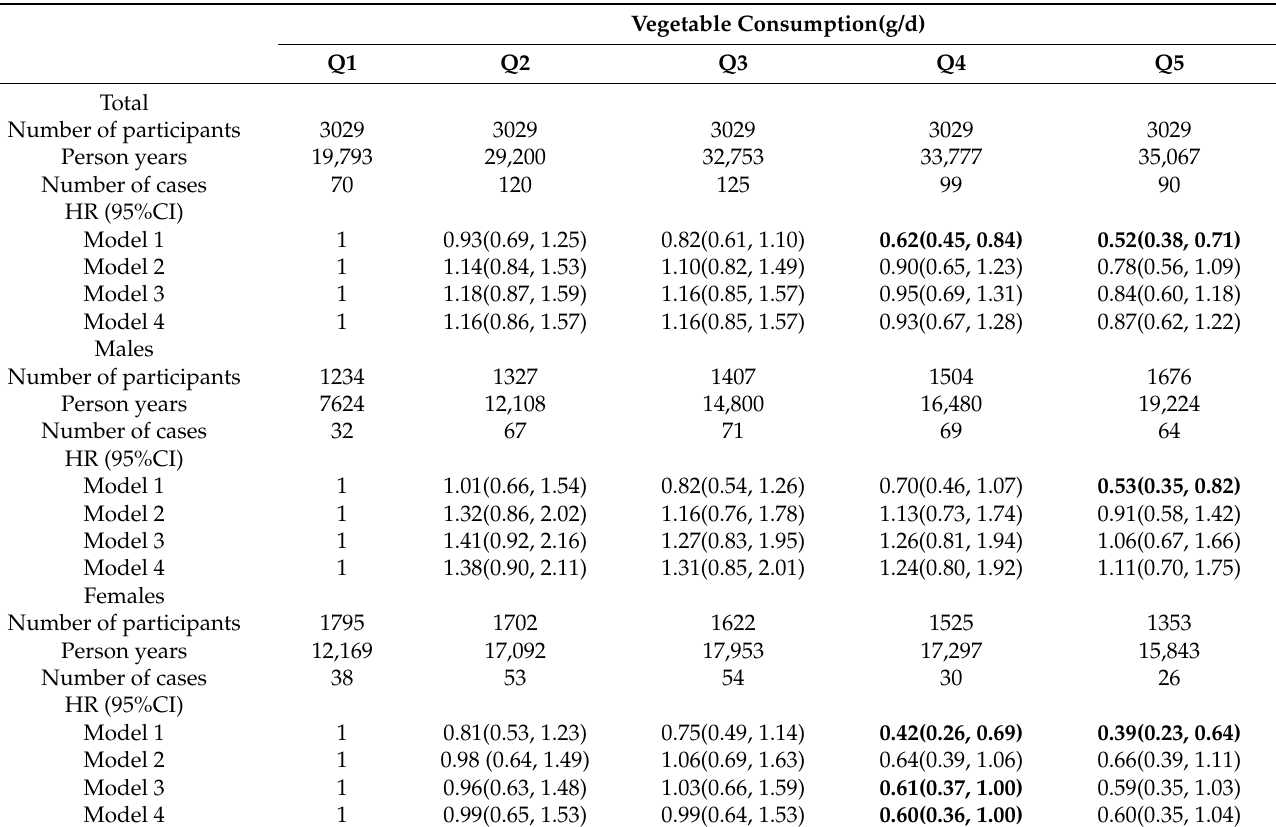
Table 2. Multivariate adjusted hazard ratios (HR) for stroke, according to vegetable consumption (CHNS study, 1991–2018).